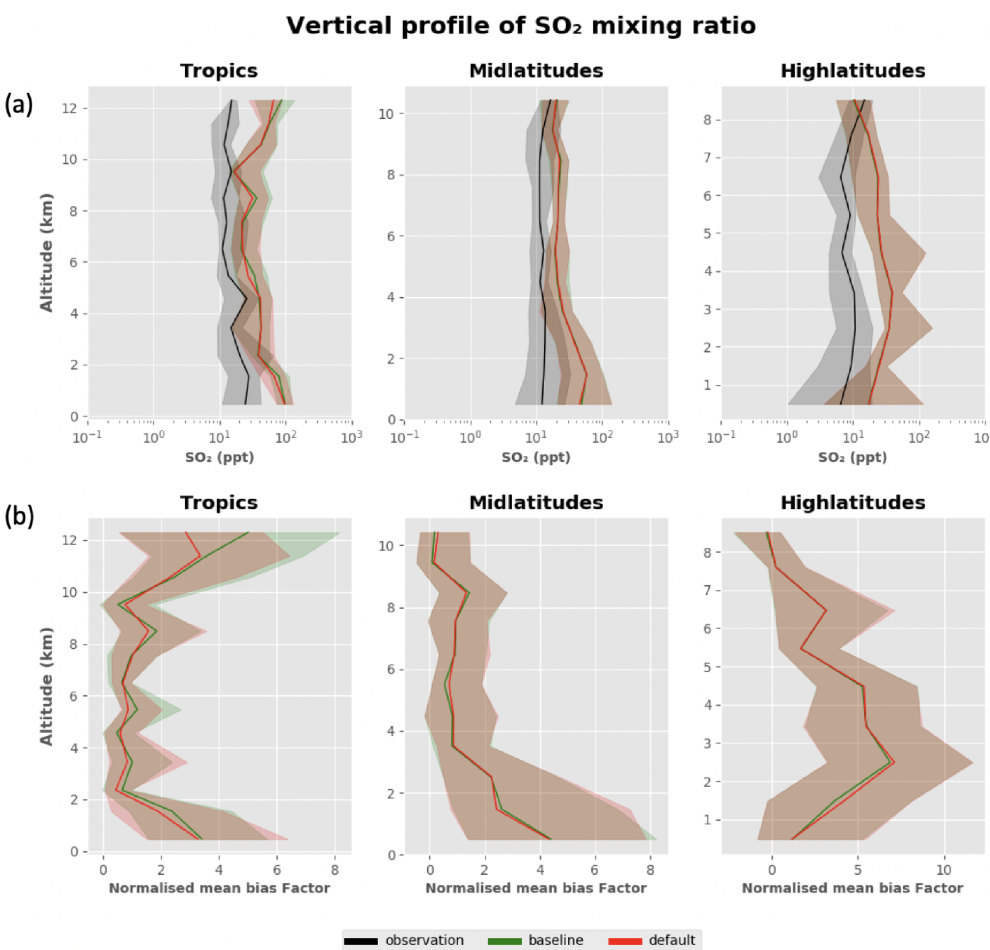
Figure A2. (a) The vertical profile of the SO 2 mixing ratio as observed (ATom4, April–May 2018) and in the simulated data from the default and baseline configurations of UKESM. (b) The vertical profile of the NMBF for the two configurations of the model. The vertical profiles have been provided for the tropics (25 ◦ N–25 ◦ S), mid latitudes (25–60 ◦ N and 25–60 ◦ S) and high latitudes (60–90 ◦ N and 60–90 ◦ S). In both (a) and (b) the bold line represents the median and the shaded region represents the corresponding interquartile range (25th and 75th percentiles) in a 1km altitude